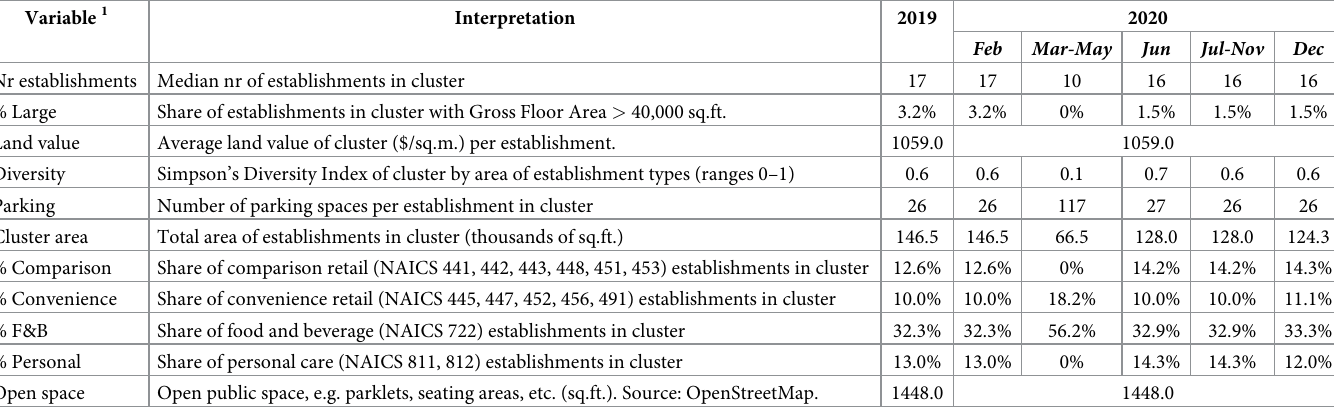
Table 1. Descriptive summary of dataset using median